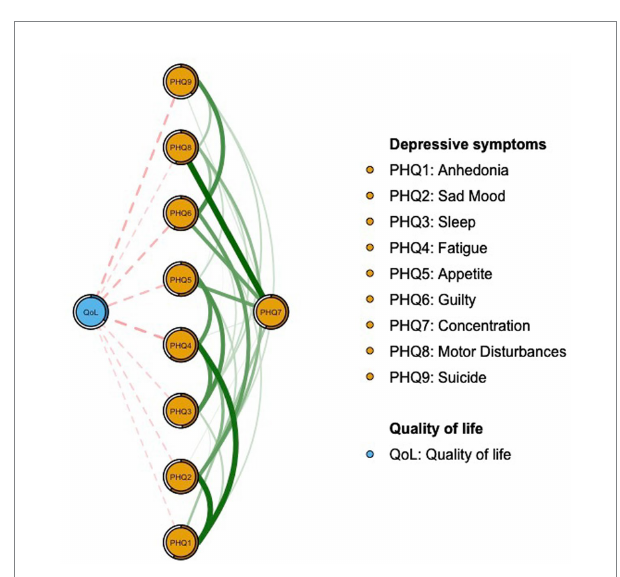
FIGURE 2 Flow network of quality of life and depressive symptoms.